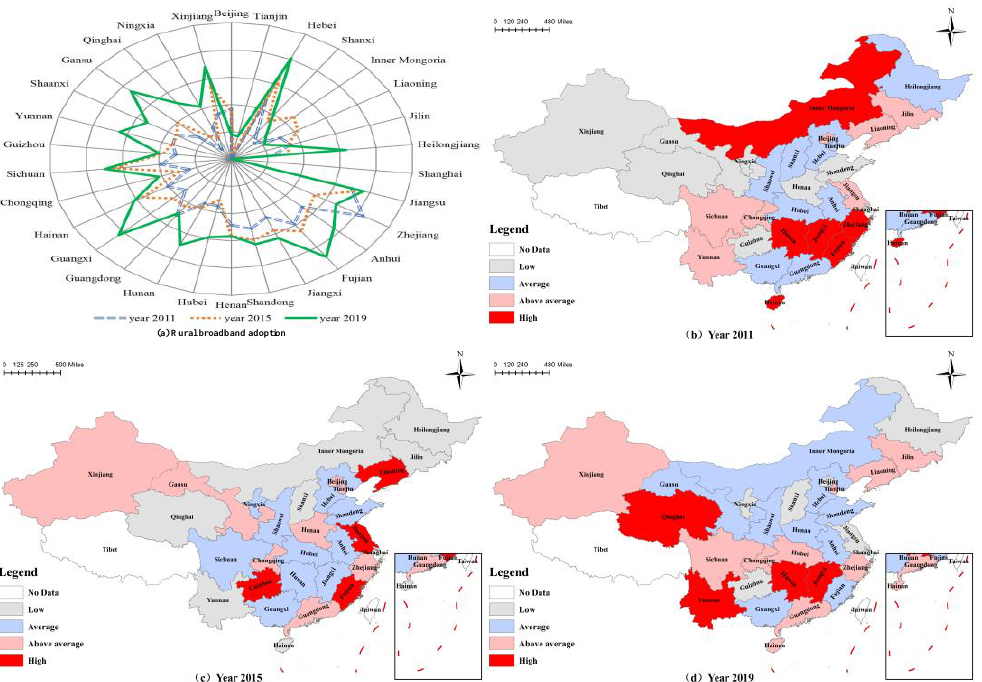
Figure 2. Spatial distribution of provincial rural broadband adaption and ACRE. Notes: There are four labels: ( a – d ).